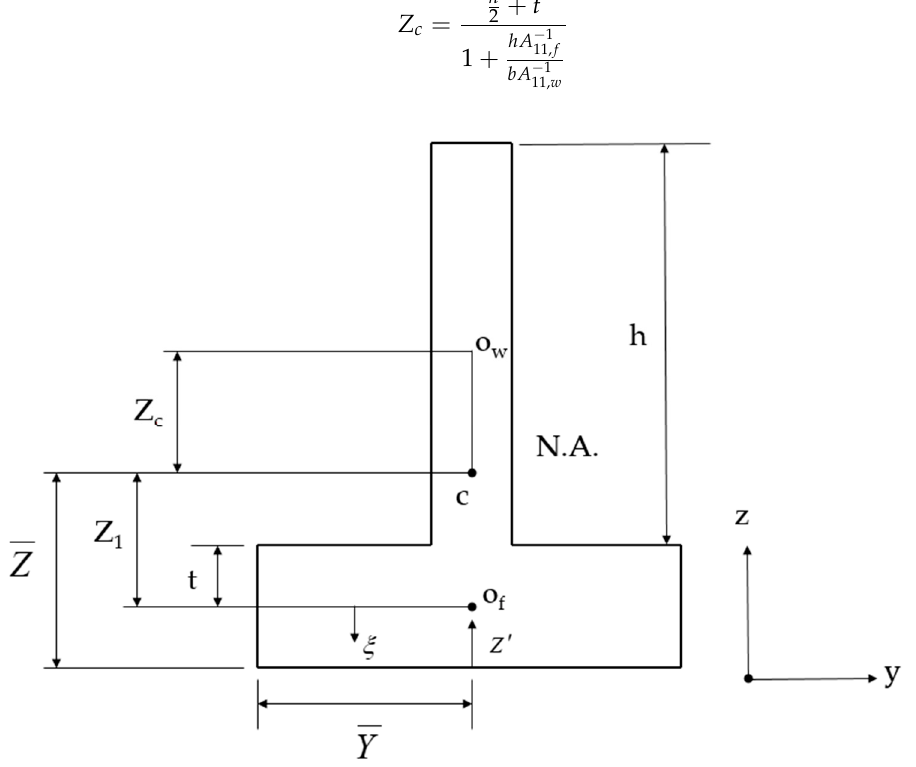
Figure 2. The A-A section of laminated T-beam.